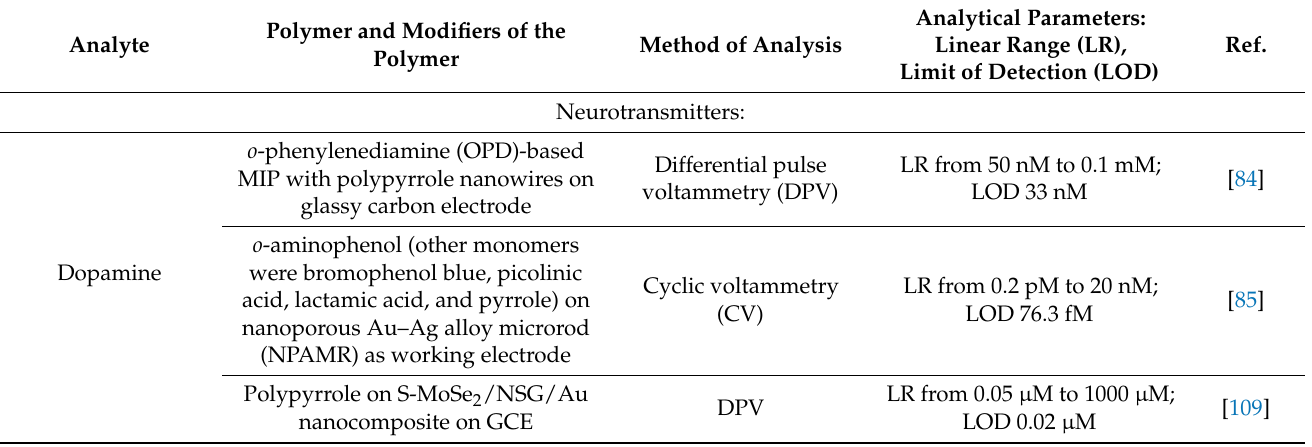
Table 1. A summary of conducting polymer-based MIPs implemented in electrochemical sensors and dedicated to the detection of some low molecular mass